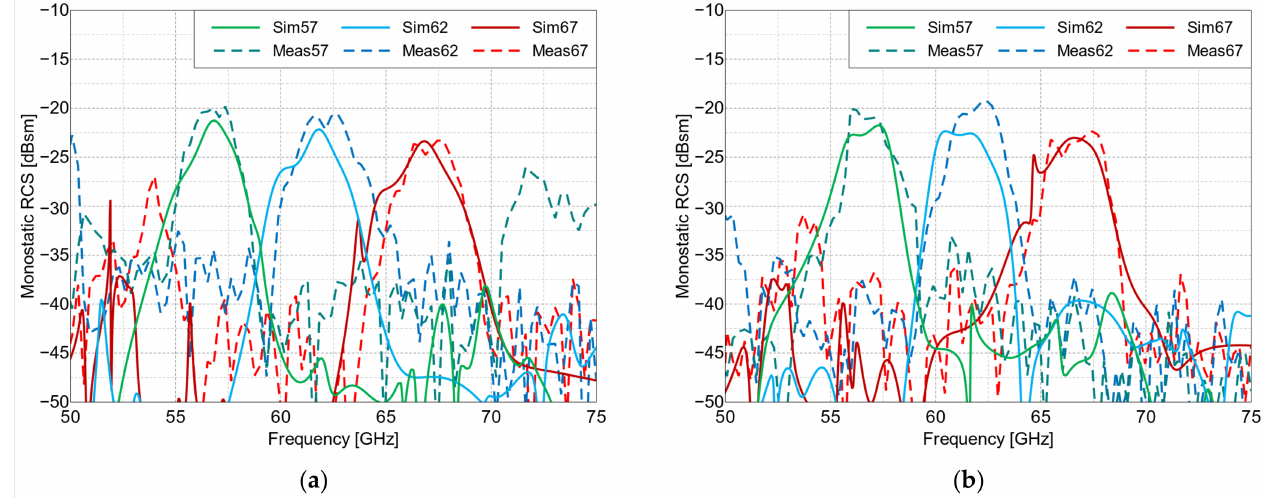
Figure 11. RCS values of the cross-polarized arrays vs. frequency, at angles of incidence of: ( a ) 0 ◦ and ( b ) 30 ◦ . Meas—measured results and Sim—simulated results. The resonance frequencies of the three manufactured Van Atta tags (in GHz) are 57, 62 and 67.